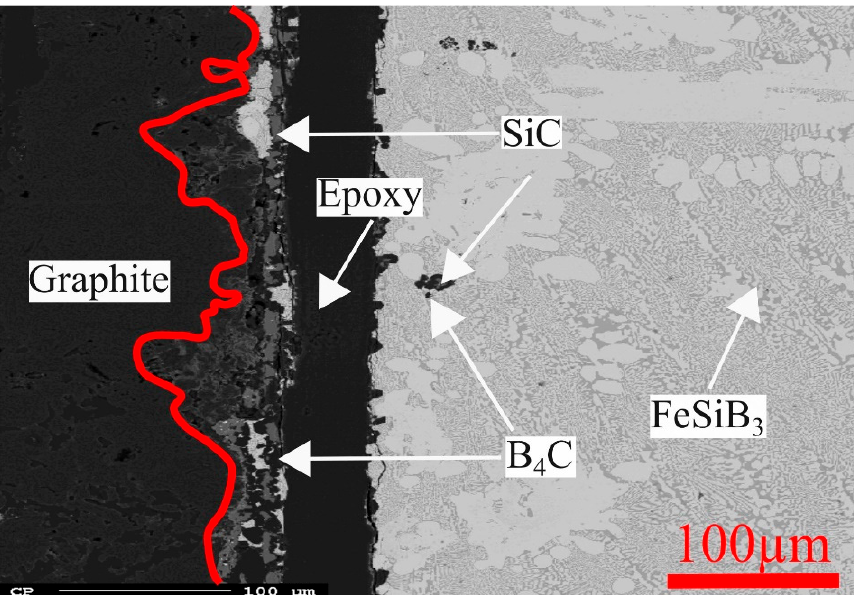
Figure 10. The distribution of phases at the interface between Fe-26.38Si-9.35B alloy and the graphite crucible after four thermal cycles at 1157 ± 100 °C.